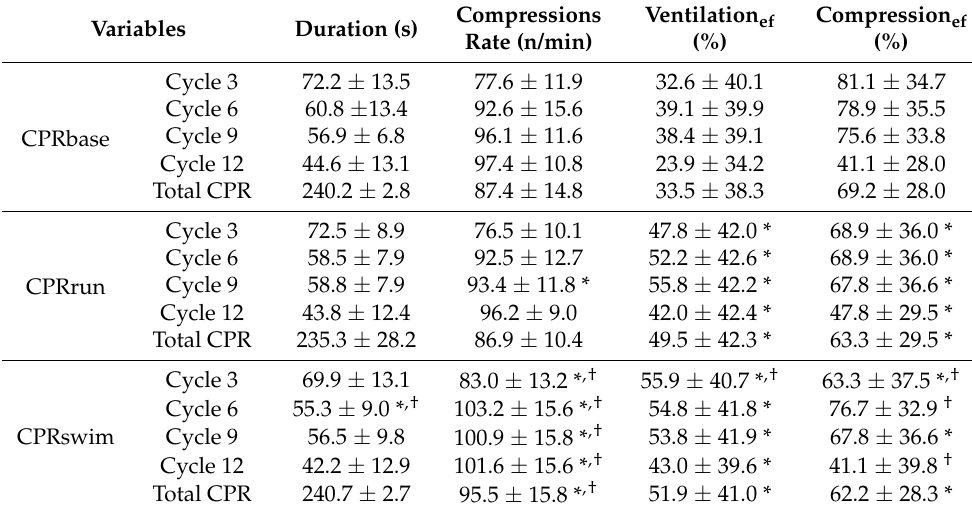
Table 2. Mean ± SD values for the technical variables assessed during CPR cycles (3, 6, 9 and 12) and total CPR in the CPRbase, CPRrun and CPRswim conditions. Variables Duration (s)